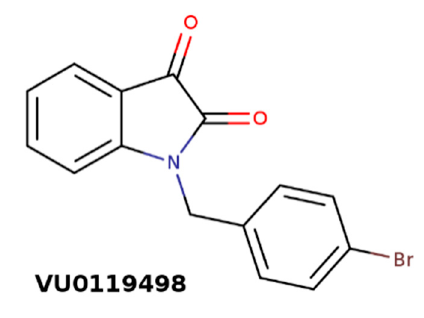
Figure 10. Structure of M 3 -selective positive allosteric modulators (PAM) of acetylcholine VU0119498.